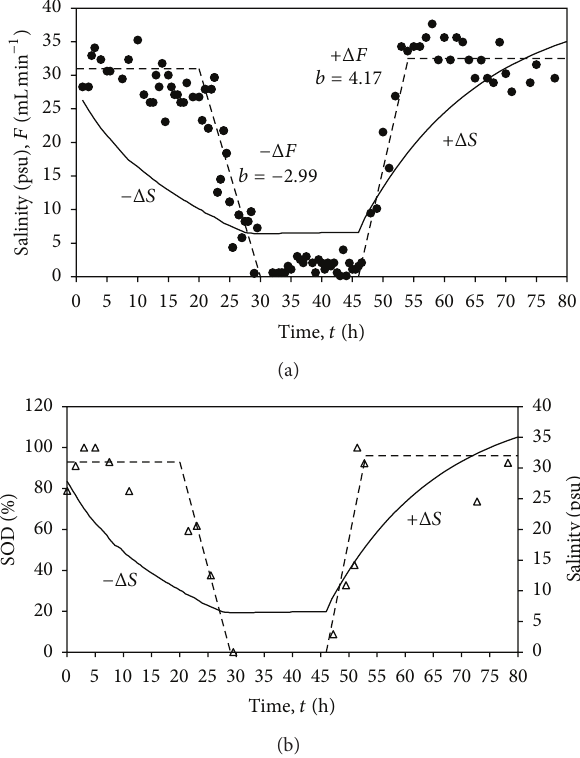
Figure 8: Mytilus edulis. (a) Salinity changing rates ( Δ𝑆 ) and simul- taneous filtration changing rates ( Δ𝐹 ) of mussels in Experiment #2 (see Table 2) (dotted horizontal line fitted by eye; dotted oblique lines = slope of regression line = 𝑏 ). (b) Shell opening degree (SOD; cf. [25]) of mussels measured from digital pictures taken during the experiment (dotted line fitted by eye).